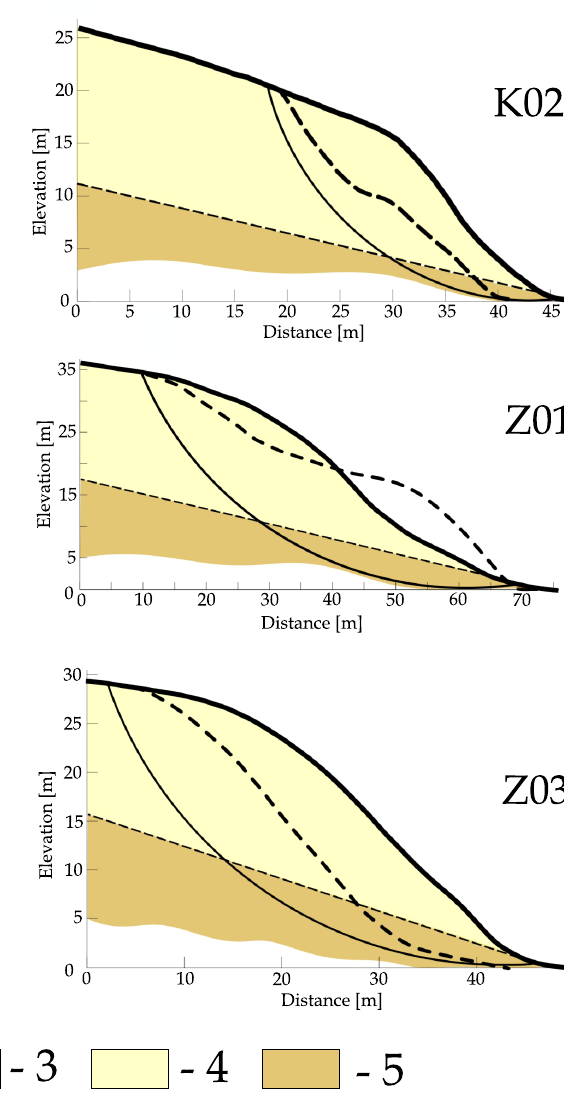
fig. 9. shape of reconstructed landslide slopes subjected to slope stability